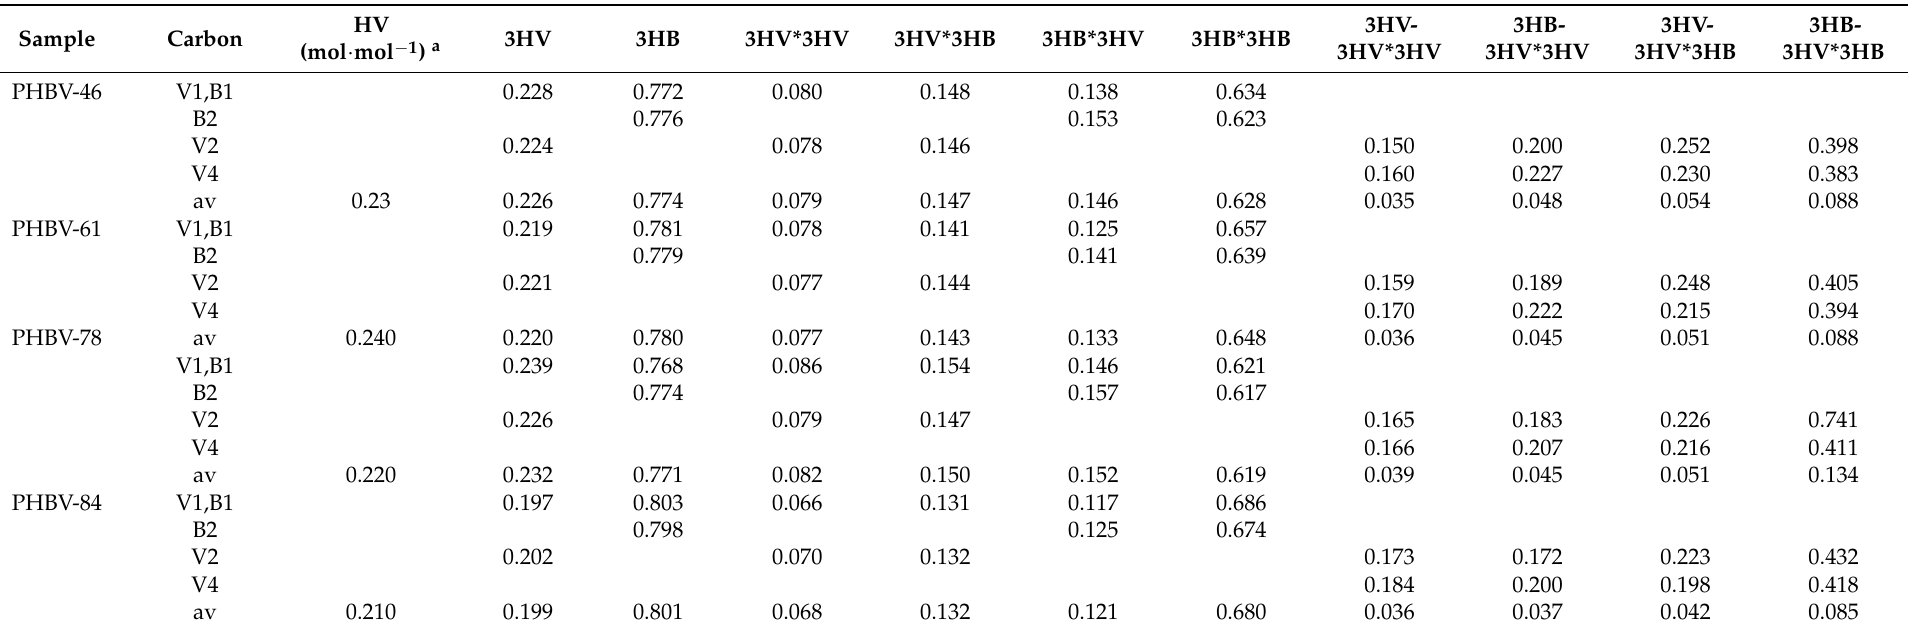
Table 5. Experimental diad and 3HV-centered triad relative peak intensities for purified PHBV from different operational